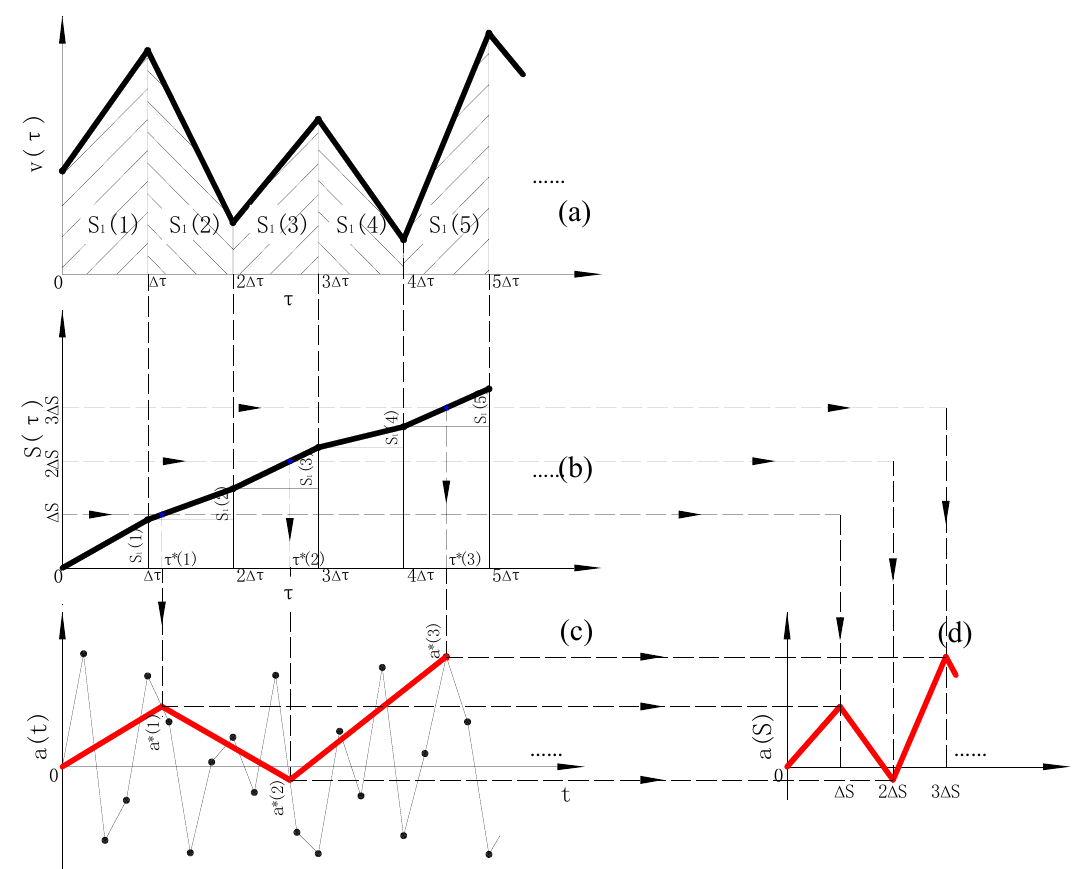
Figure 2. Acceleration history time-space